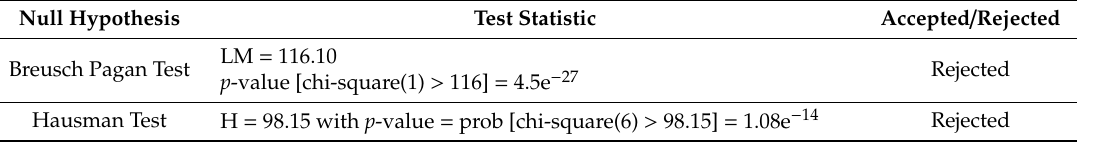
Table 5. Panel Diagnostic Tests for Adjusted Lerner Estimates. Panel Period: 1996–2016. Null Hypothesis Test Statistic Accepted /